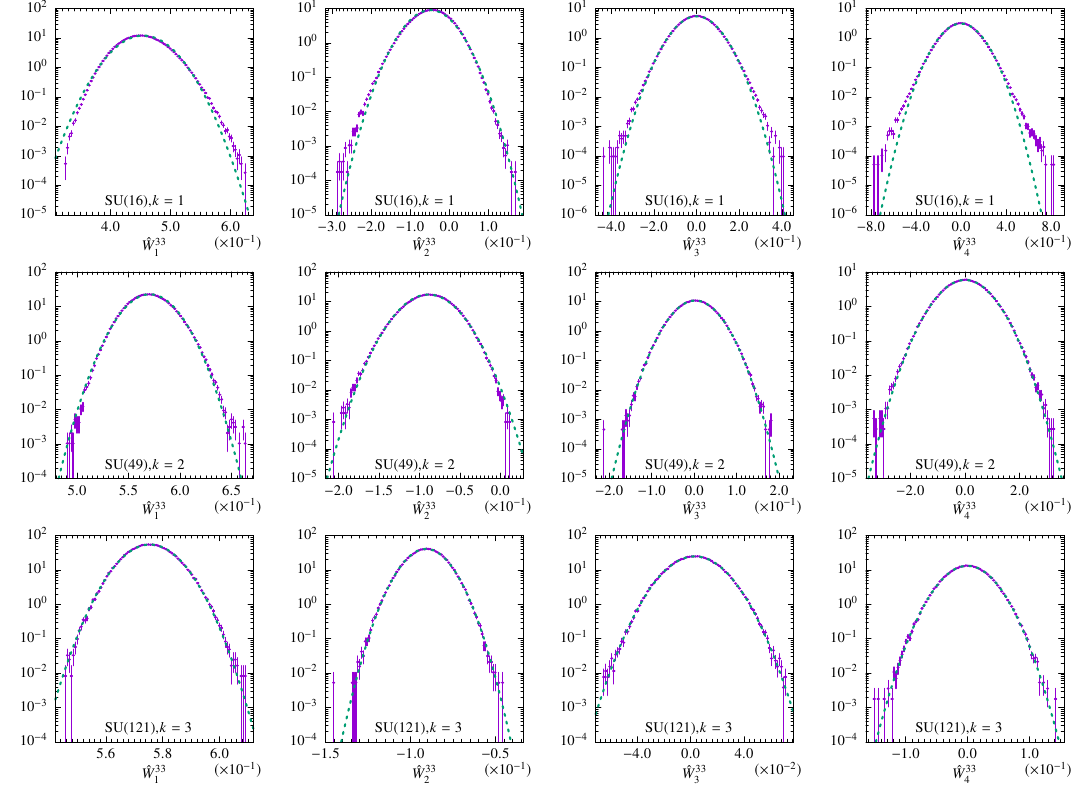
Figure 6. Same as (cid:12)gure 5, but for ^ W 33